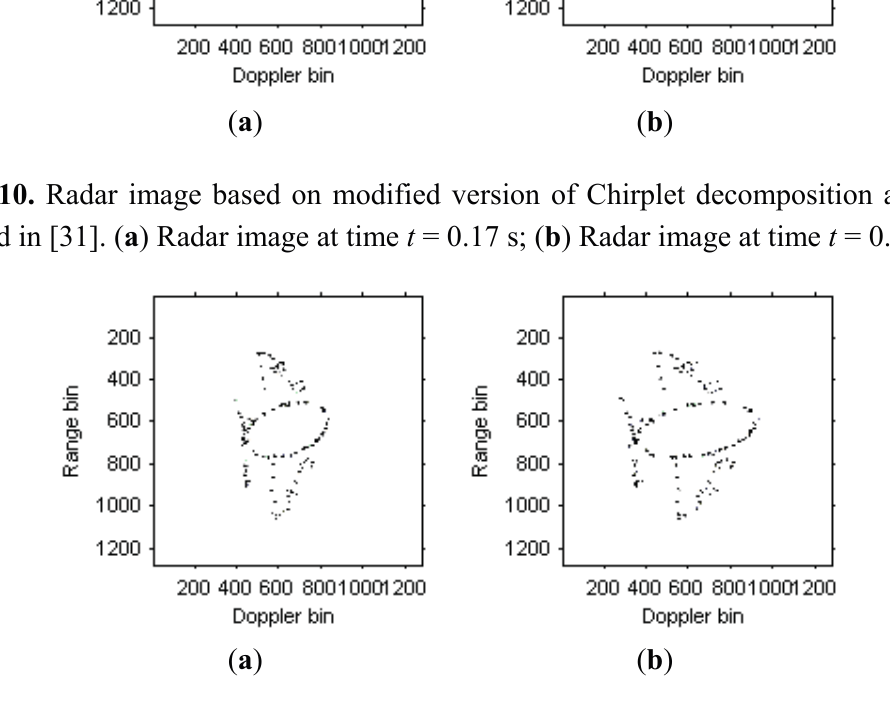
Figure 11. Radar image based on modified version of Chirplet decomposition algorithm proposed in this paper. ( a ) Radar image at time t = 0.17 s; ( b ) Radar image at time t = 0.22 s.